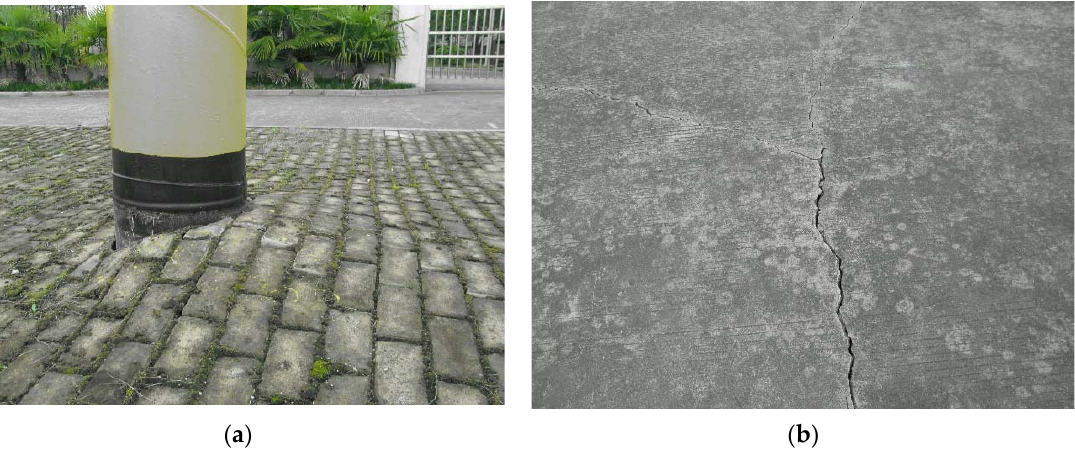
Figure 3. Ground conditions on the site: ( a ) the ground heaved at the pipeline into the ground l; ( b ) the ground heaved and cracked at the buried pipe.